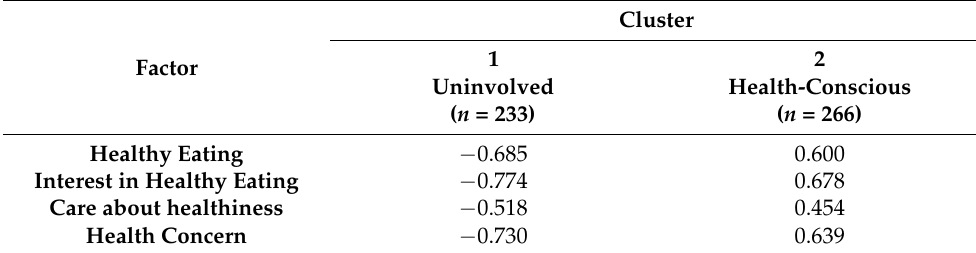
Table 3. Categories of final clusters in the